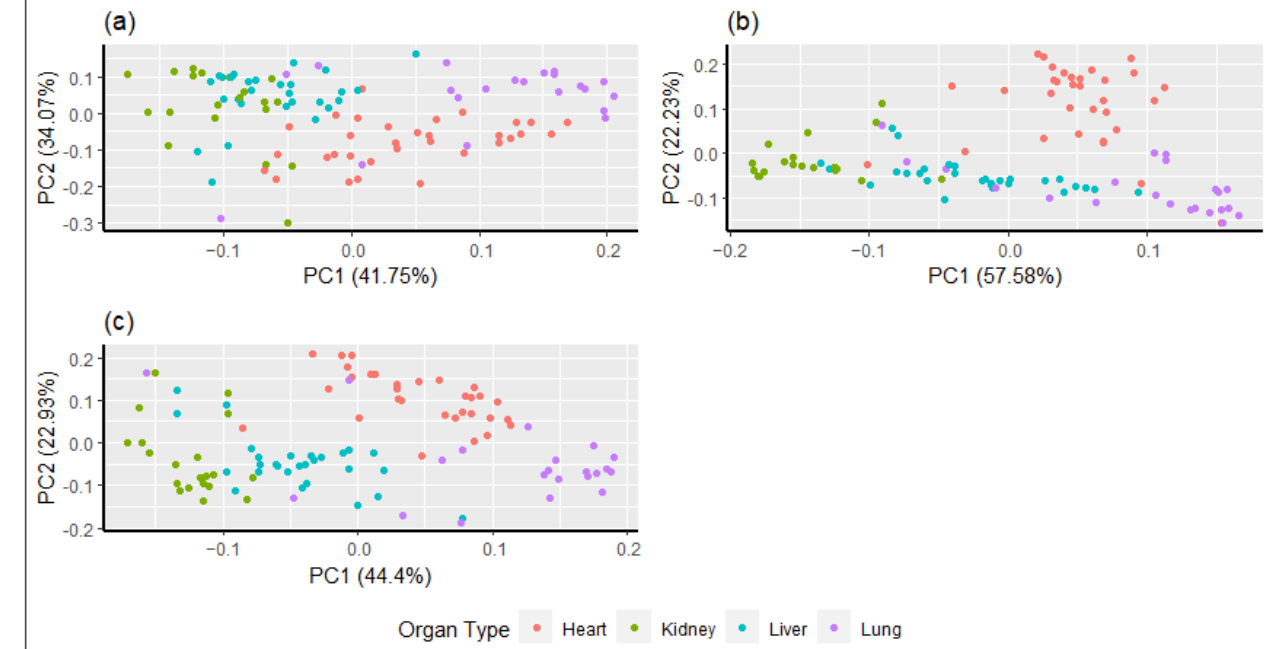
Figure 5. Principal components analysis (PC1 vs. PC2) plots for the first derivative of absorbance hyperspectral data of ( a ) visible (VIS); ( b ) short-wave infrared (SWIR); and ( c ) combination VIS and SWIR spectra for classification of bovine and ovine parenchymatous organs by type.